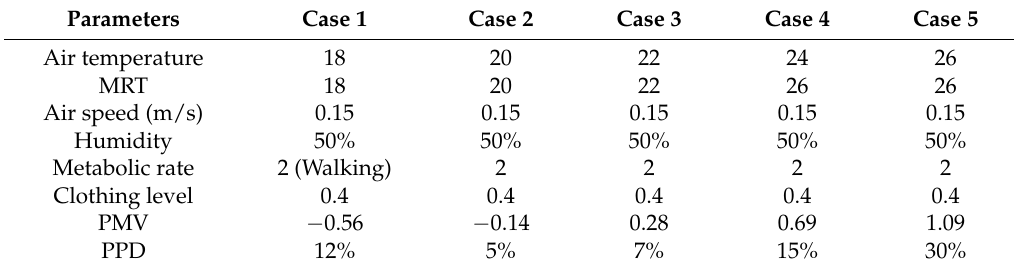
Table 4. PMV (predicted mean value) and PPD (predicted percentage of dissatisfied) Values for five (5) different air temperatures used in the